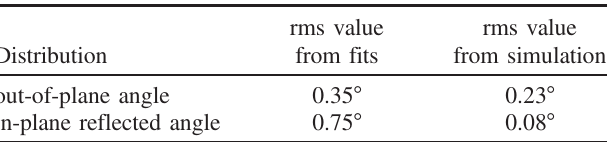
TABLE IX. Comparisons between rms Gaussian widths of the specular component from fits to the angular distribution and from simulation.